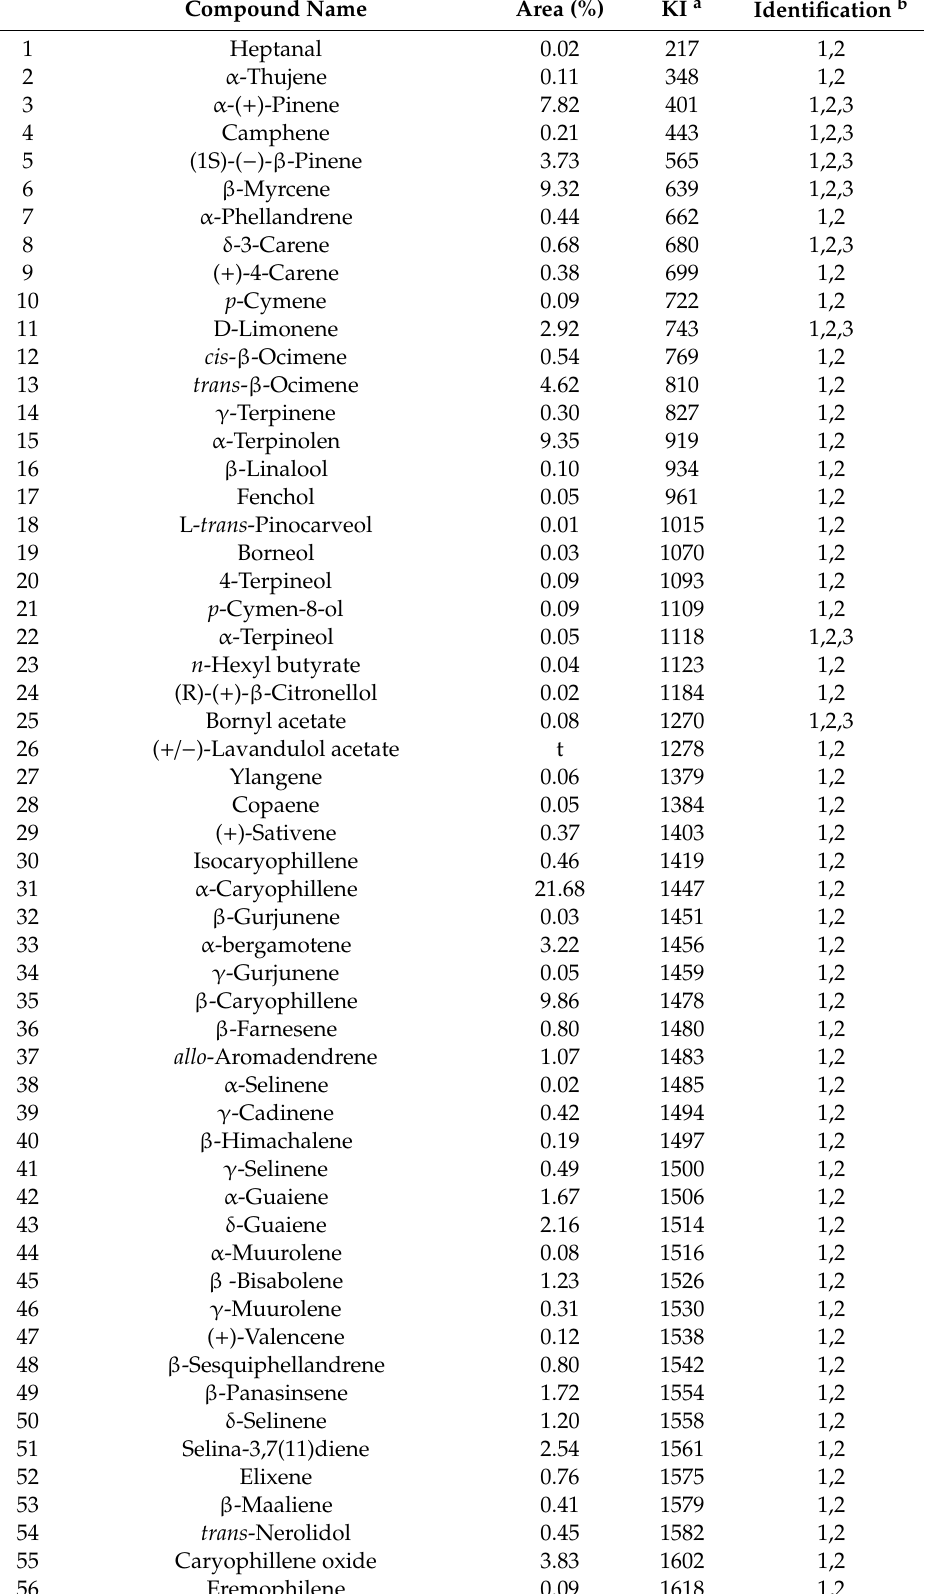
Table 1. Chemical composition of C. sativa L. var. Futura 75